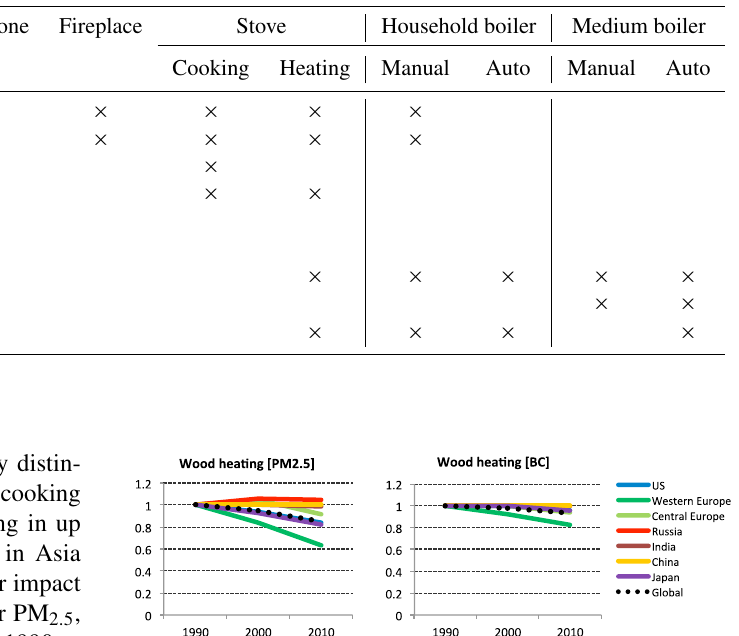
Gaseous fuels Liquid fuels Charcoal